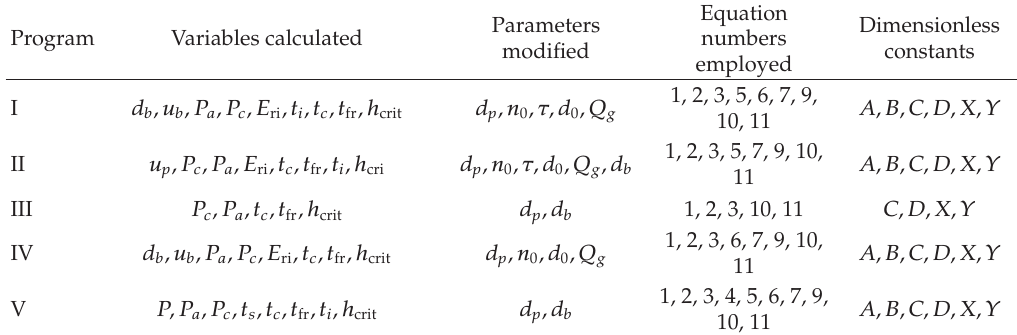
Table 1: Variables, parameters, and equations for each program